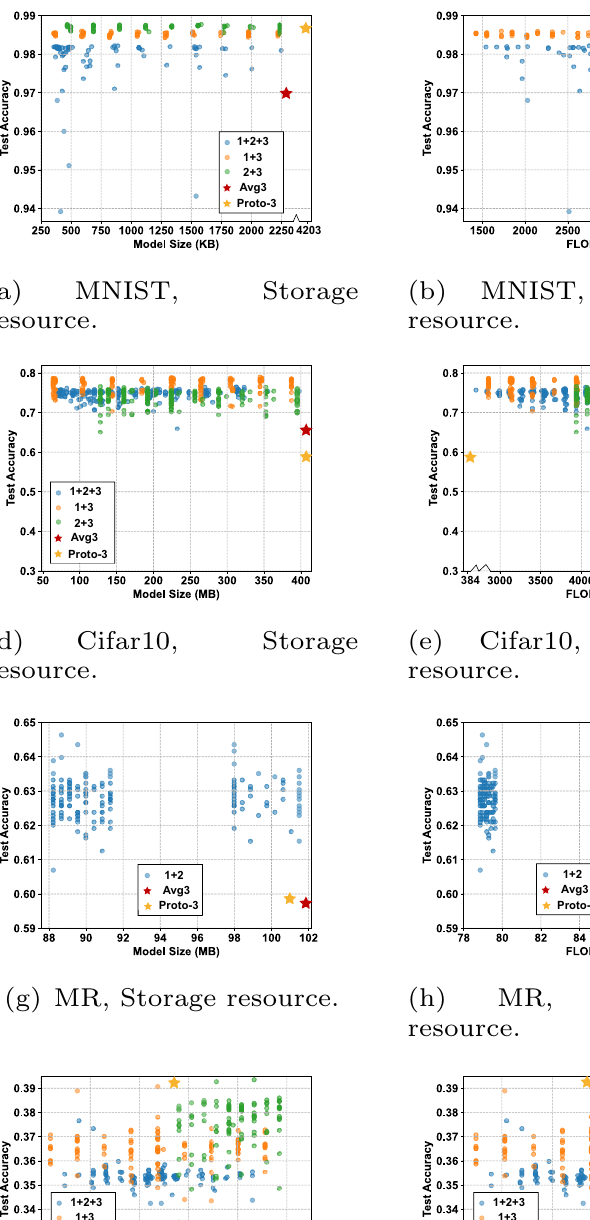
cation resource.